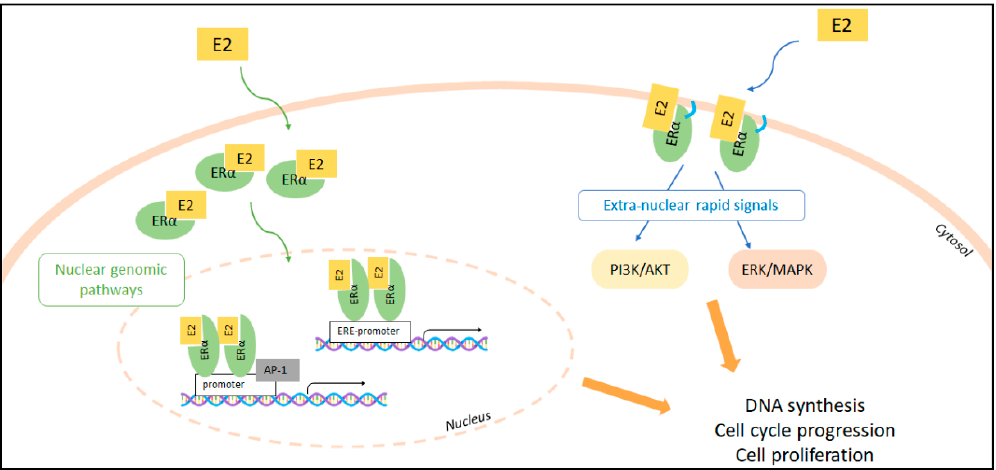
Figure 1. E2:ER α nuclear and extra-nuclear signaling to cell proliferation. The nuclear (left) and extra-nuclear (right) signaling pathways are indicated. Localization of the ER α to the cell plasma membrane by palmitoylation is indicated (blue sign). E2:ER α -dependent transcription of the genes containing or non-containing the estrogen response element (ERE) within their promoters as well as E2:ER α -dependent activation of the classic PI3K/AKT and ERK/MAPK kinase cascades are indicated. 17 β -estradiol (E2); estrogen receptor α (ER α ); Activator Protein 1 (AP-1); estrogen responsive element (ERE); phosphatidyl-inositol-3-kinase (PI3K); v-akt murine thymoma viral oncogene homolog 1 (AKT); mitogen-activated protein kinase (MAPK); extracellular regulated kinase (ERK).